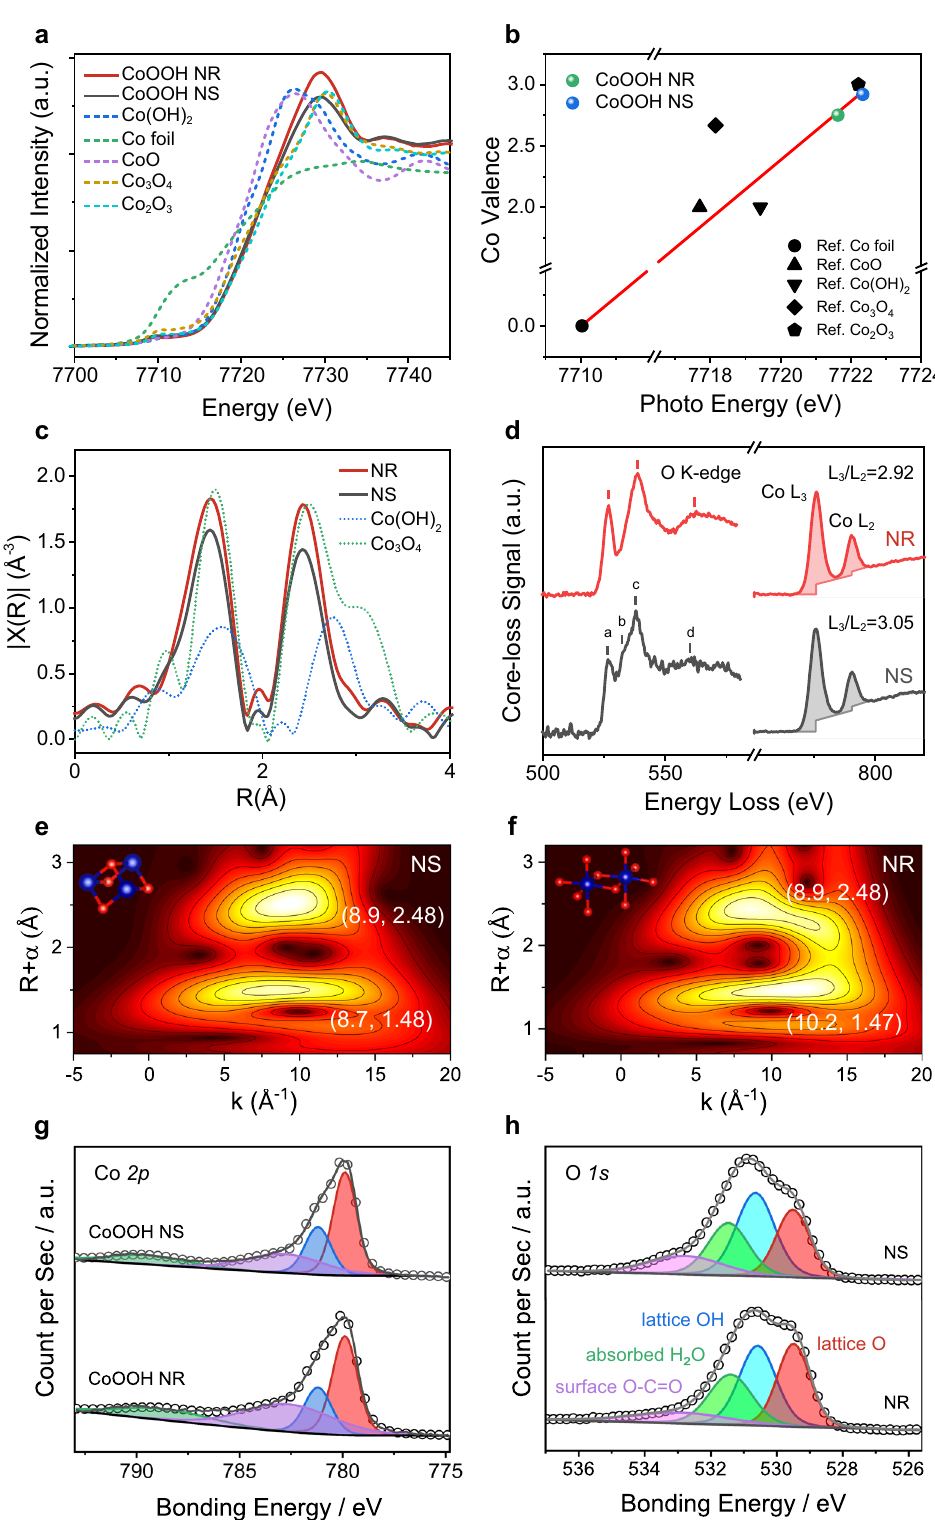
Fig. 2 | X-ray absorption, electron energy loss, and X-ray photoemission spectra of CoOOH NS and NR.a XANES spectraofcobalt K-edgefor NR (red) and NS (black). Reference samples of Co(OH) 2 (blue), Co foil (green), CoO (purple), Co 3 O 4 (yellowish-brown), and Co 2 O 3 (purple) are included; b Fitted oxidation statesofCoforNR(greenpoint)andNS(bluepoint); c Fouriertransform(FT)ofCo